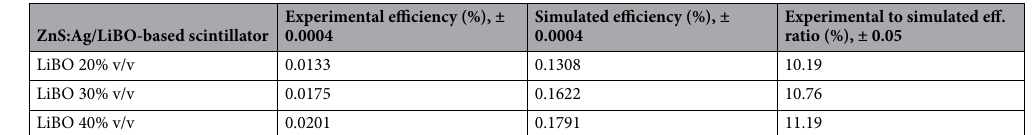
Experimental efficiency (%), ± 0.0004